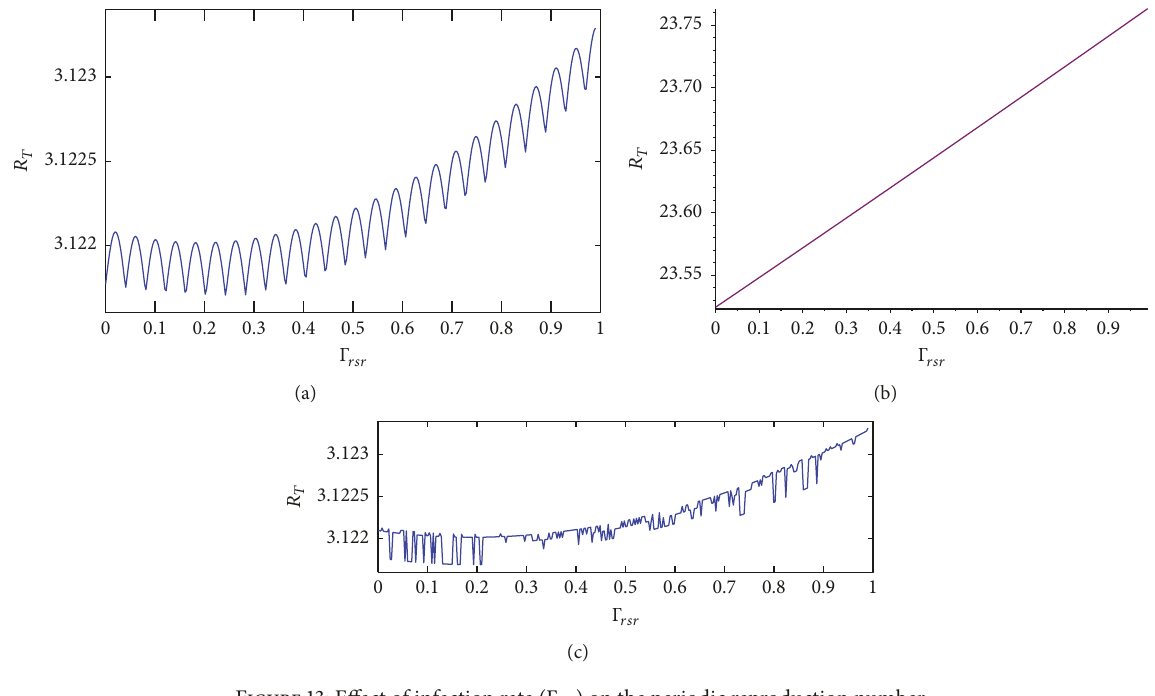
Figure 13: Effect of infection rate ( Γ 𝑟𝑠𝑟 ) on the periodic reproduction number.